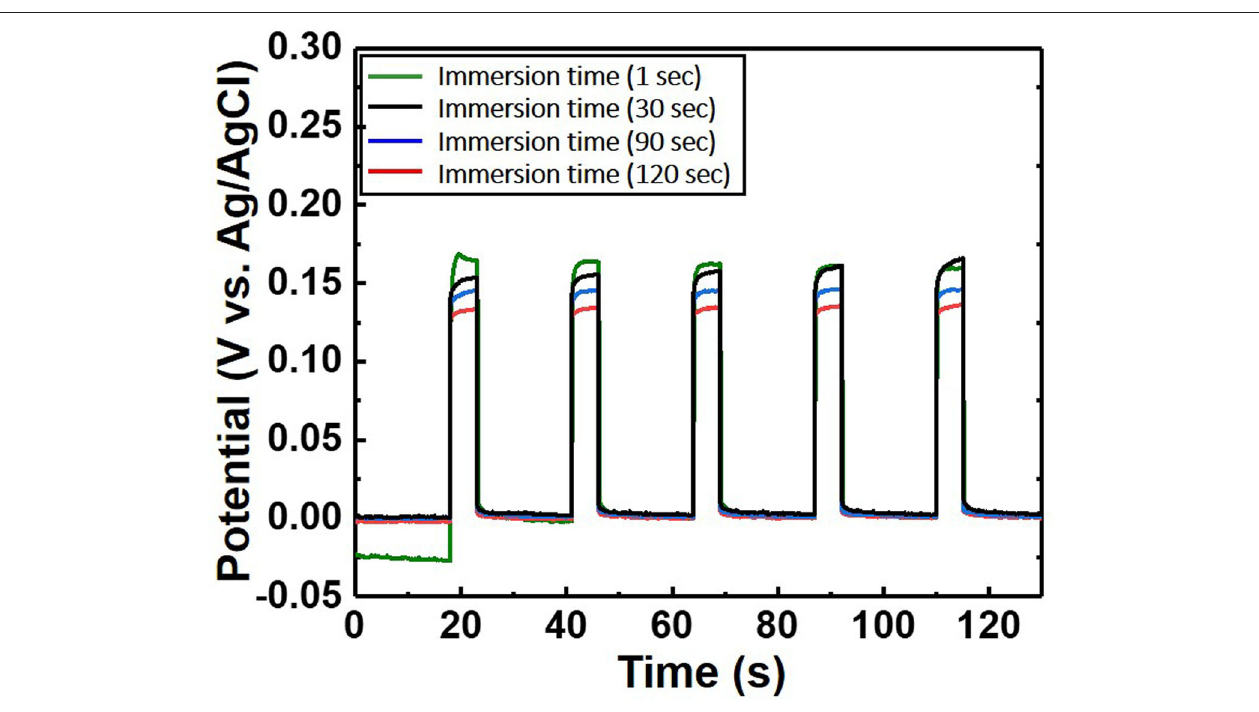
FIGURE 5 | Potential difference of the chloride ion sensor as a function of immersion time. The electrolyte comprises 300mM KCl and 0.5M KNO 3 . The length of the Ag/AgCl wire and the distance between the Ag/AgCl wire and diatomite ceramic membrane are fixed at 3 and 1cm,